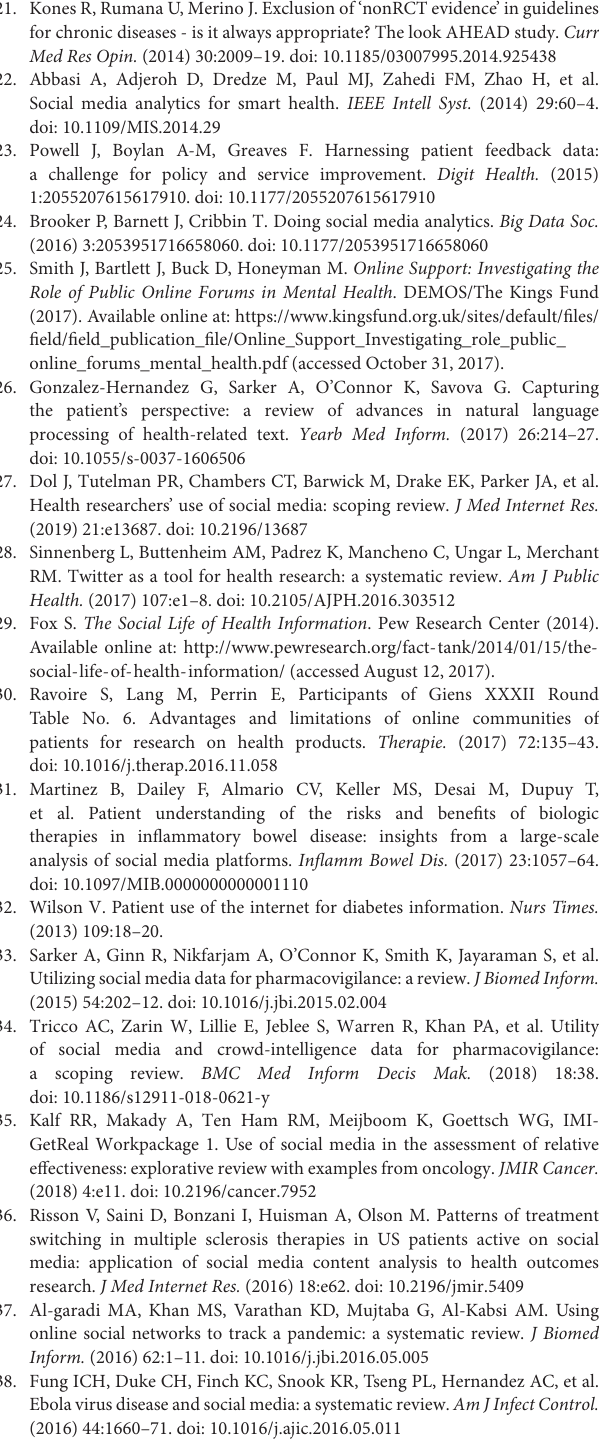
Table No. 6. Advantages and limitations of online communities of patients for research on health products. Therapie. (2017)